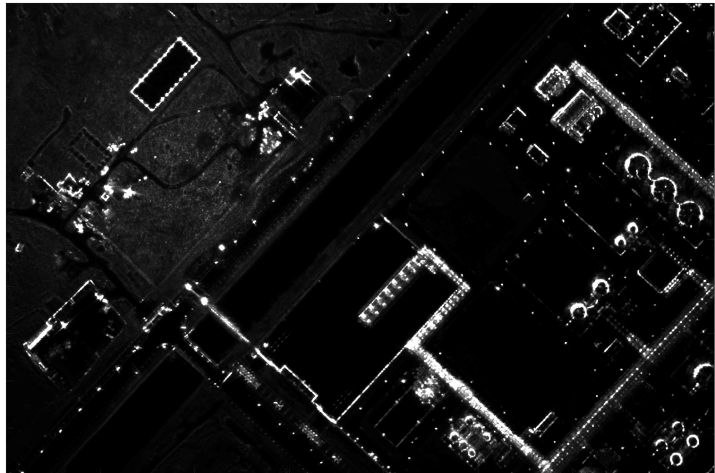
Figure 14. The likelihood ratio image obtained by G 0 approach.